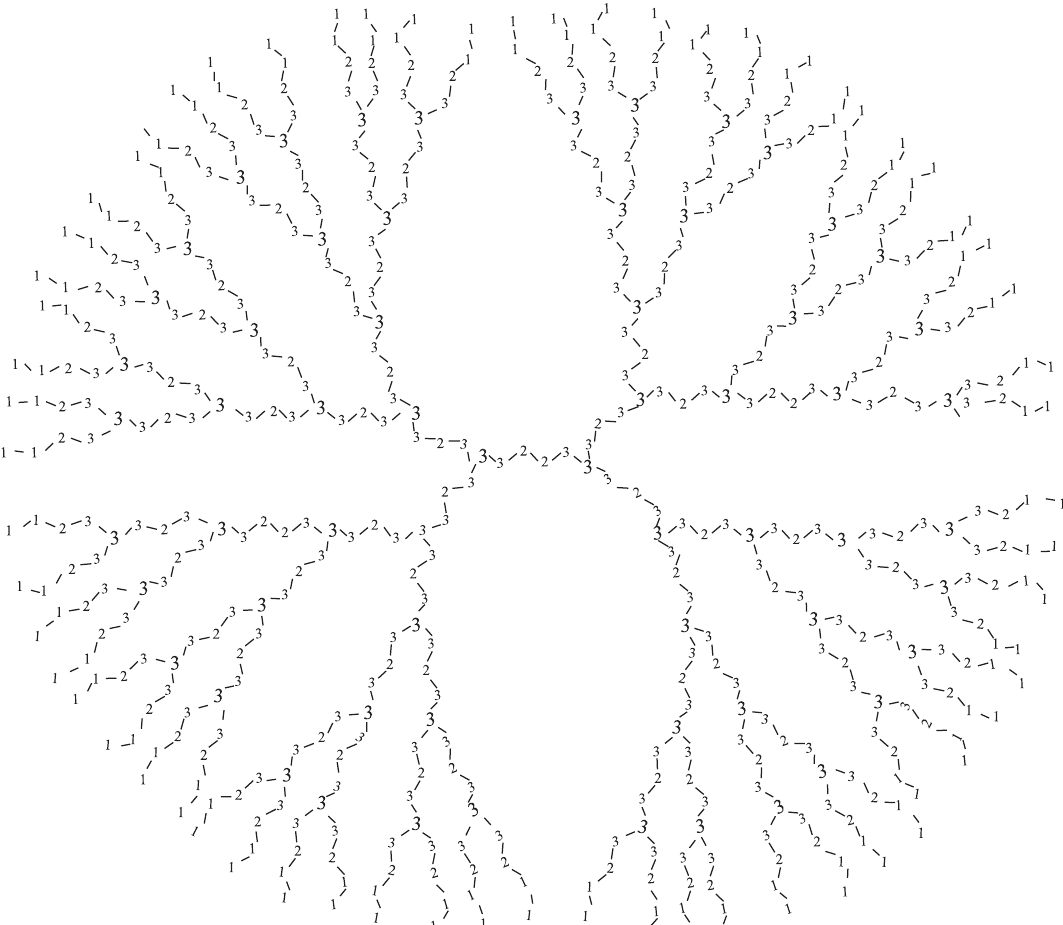
Figure 4: Structural formula of PPIO dendrimer for t � 5 along with